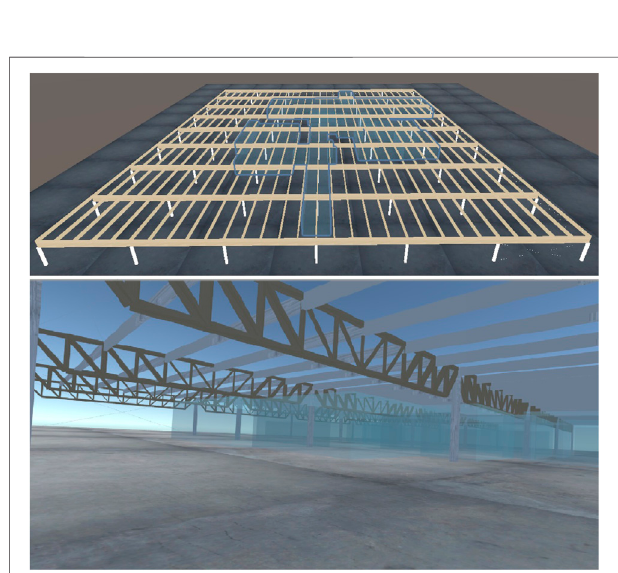
FIGURE 8 | Examples of parametrically-generated industrial buildings in BIMFlexi-VR. Top: top-down view in the Unity3D editor; bottom: a screenshot from thepoint ofviewofanimmersed user.Semi-transparent elementsdepict production layouts - areas that would be occupied by the production